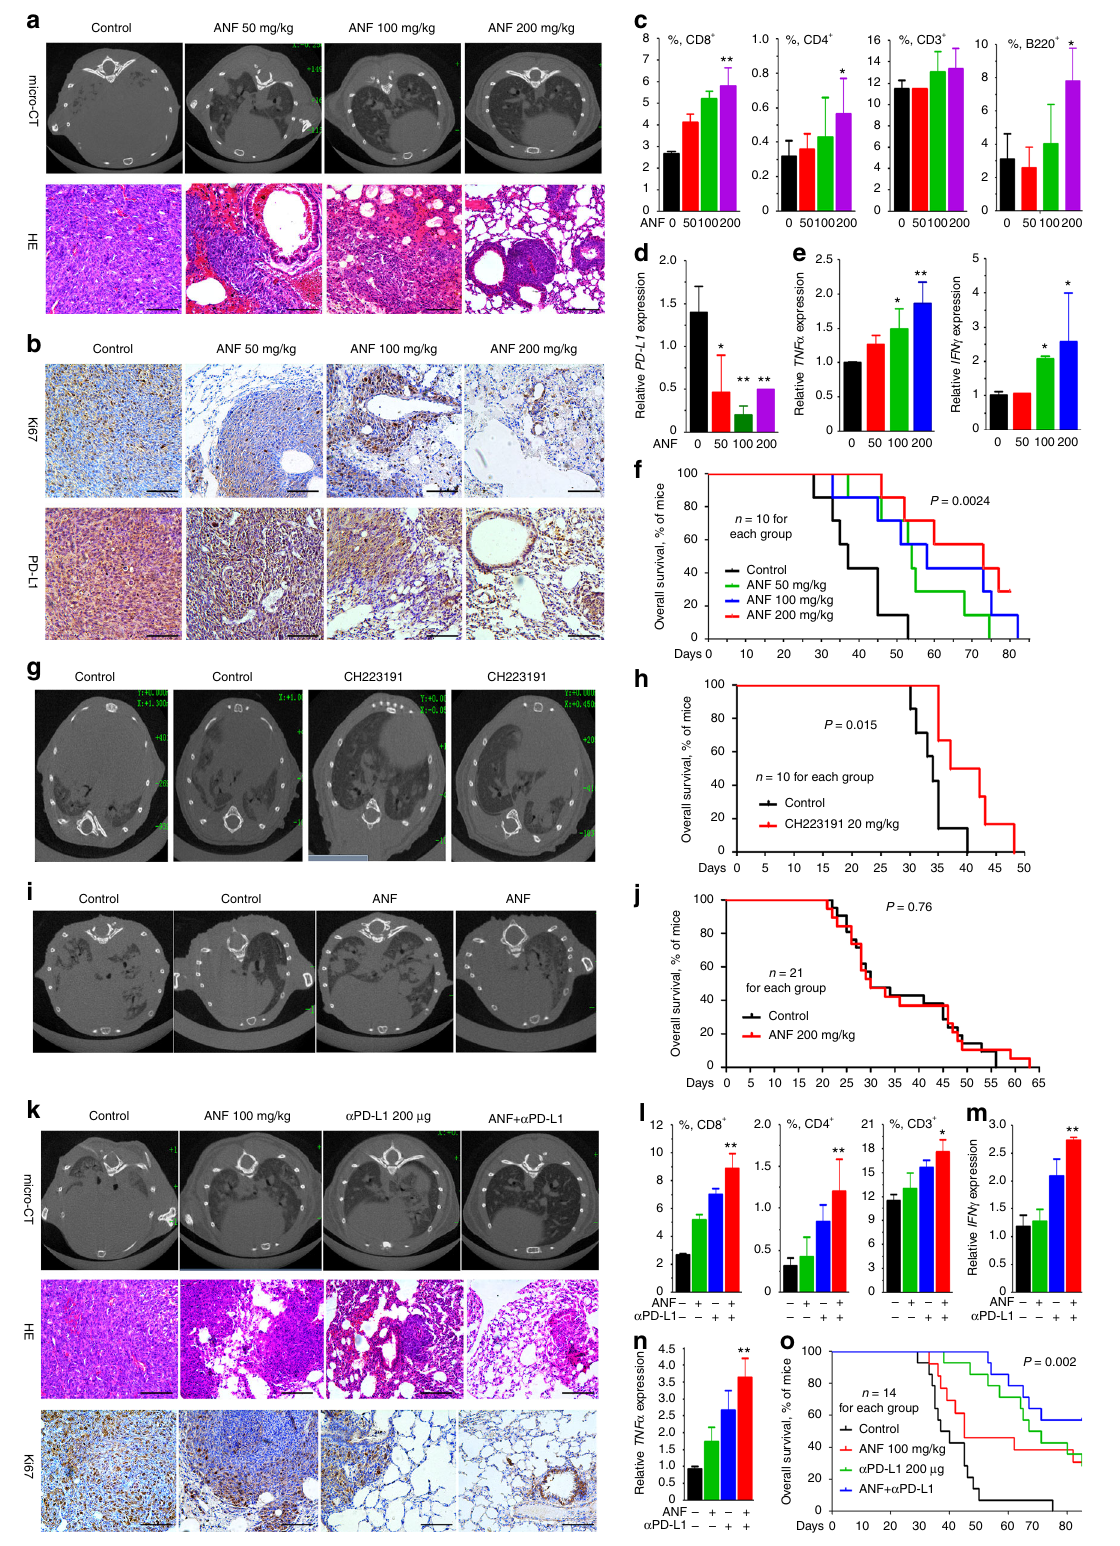
(Table 2) previously treated with cisplatin-based chemotherapies were enrolled, tumor biopsy specimens were collected and analyzed by IHC using an